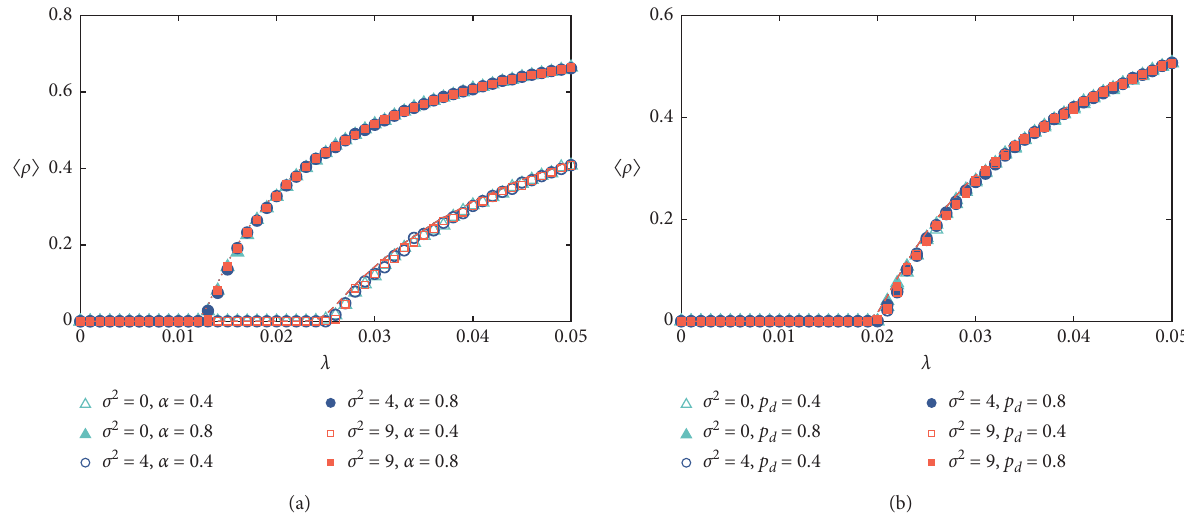
Figure 2: Financial risk information spreading on metapopulation networks. (a) The fraction of individuals in the active state 〈 ρ 〉 versus information transmission probability λ with travelling probability p d � 0 . 5. (b) 〈 ρ 〉 versus λ with α � 0 . 5. The average weight is set to be 〈 w 〉 � 10 and recovery probability μ � 0 . 2. The lines stand for the theoretical analysis and symbols represent the numerical simulation